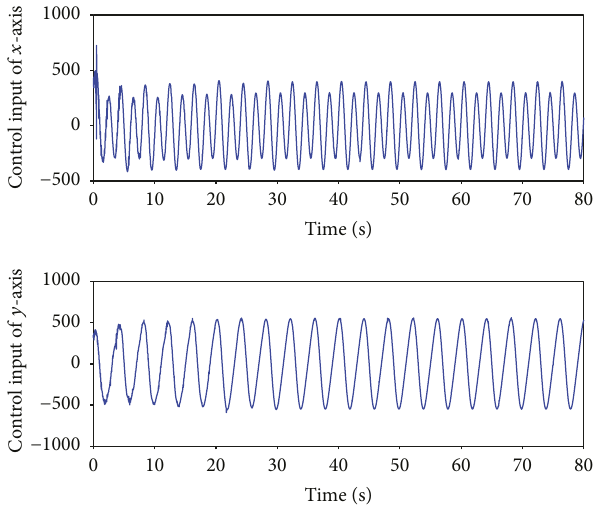
Figure 8: Control input signals.